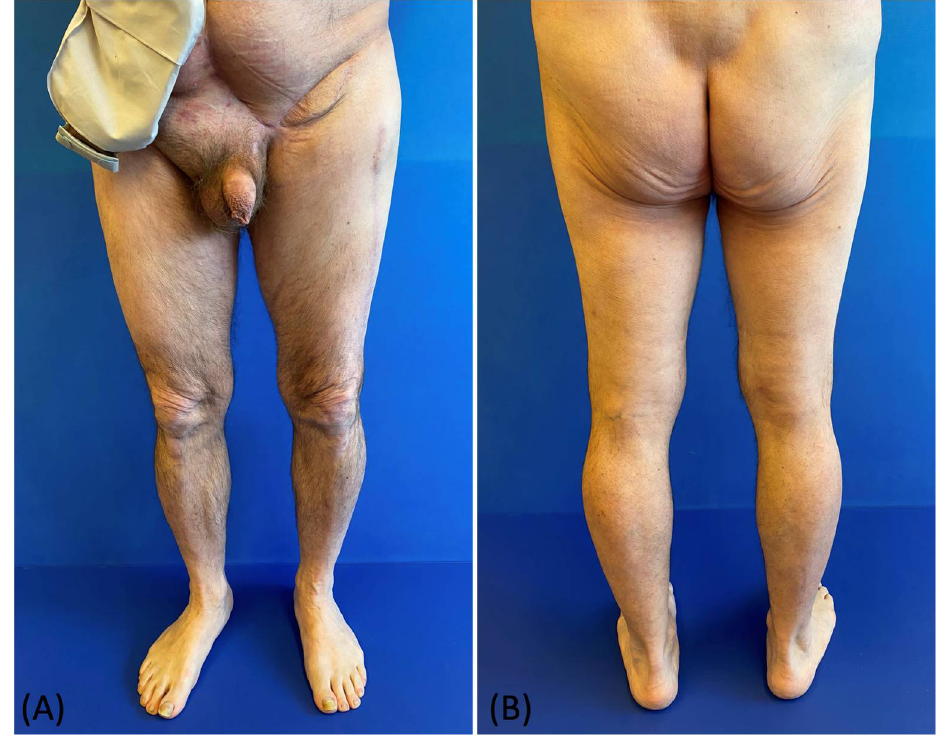
Figure 6. ( A , B ) Postoperative picture at 6 months follow-up: frontal view and posterior view.